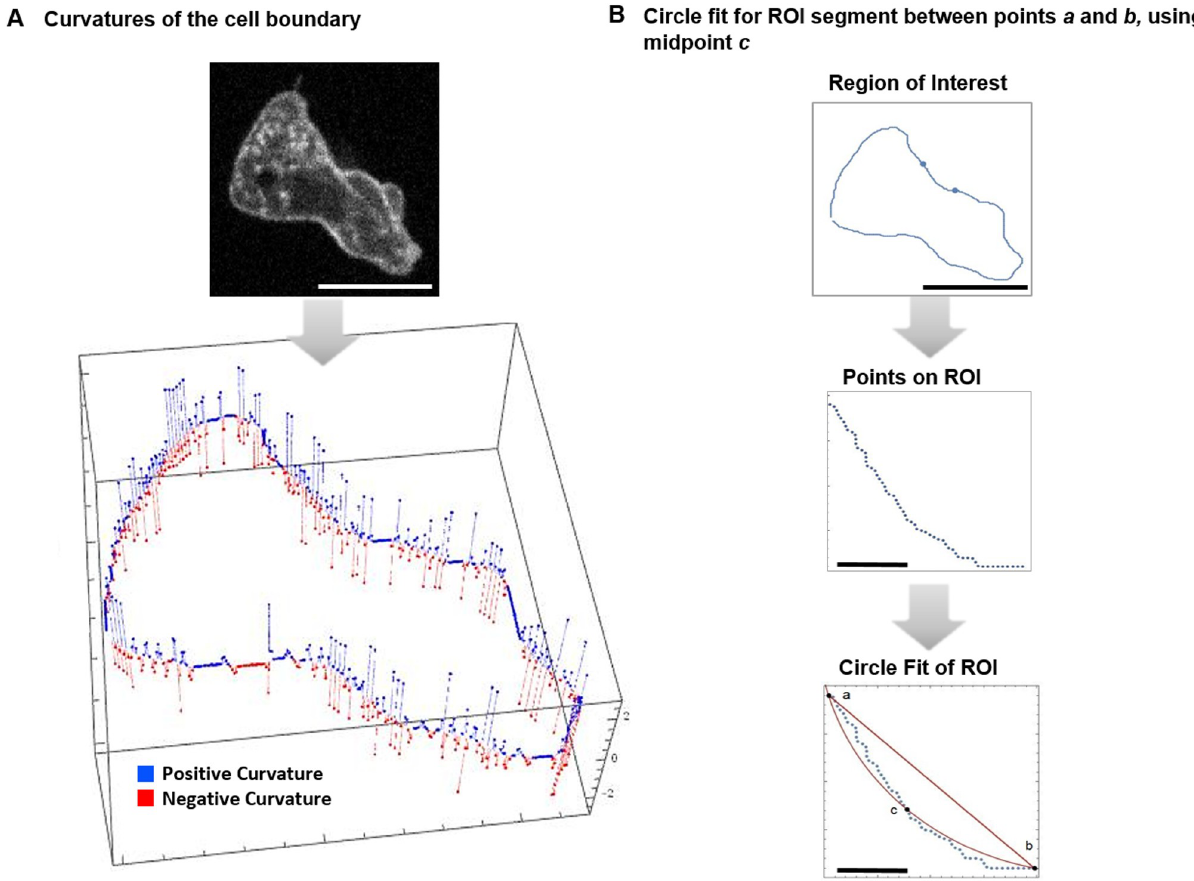
Fig 8. Curvature and relative curvature. (A) Cell boundary with positive (blue) and negative (red) curvature values identified. This plot demonstrates the chaotic nature of raw curvature measurements. (B) The relative curvature between the points a and b . The fitting circle passes through c . The relative curvature value is − 0.05097. Scale bars are 10 microns and 1 micron for the ROI.